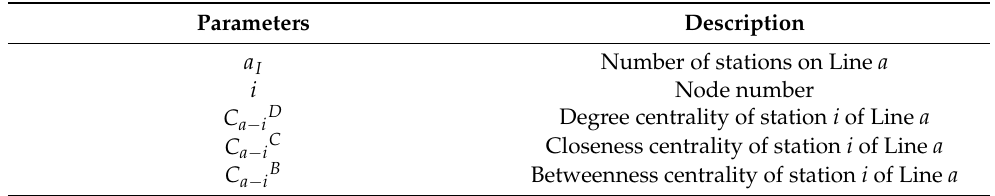
Table 7. Description of formula